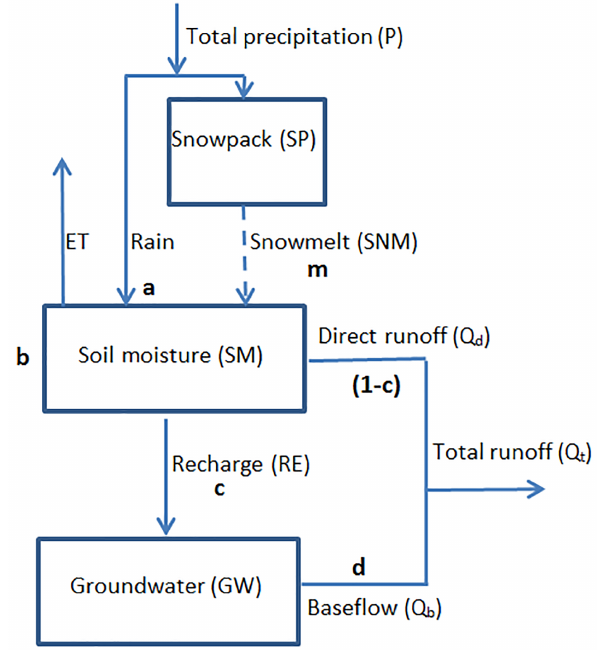
Figure 1. Schematic diagram of the abcd model, with enhance- ments of snow and partition of total runoff between direct runoff and baseflow.